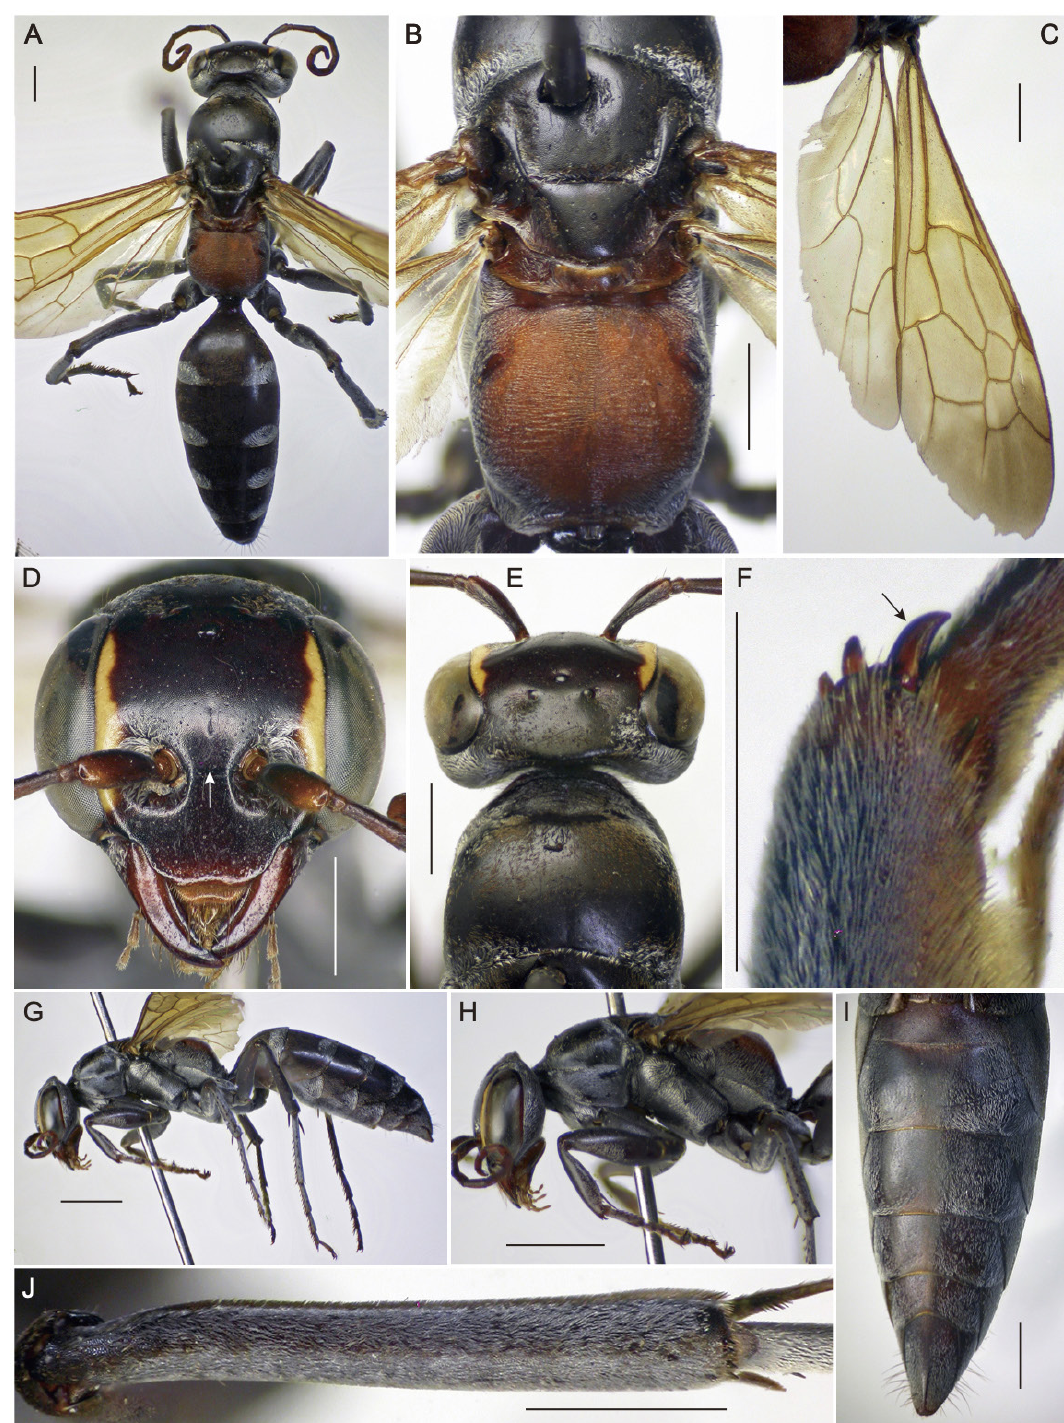
Fig. 3. Ctenocerus srilankae Shimizu sp. nov., holotype, ♀ (NMNH). A . Whole body, dorsal view. B . Posterior part of mesosoma, dorsal view. C . Right wings. D . Head, anterior view, arrow indicates frontal bridge. E . Head and pronotum, dorsal view. F . Apical part of left fore tibia, mesial view, arrow indicates apicomesial spine on fore tibia. G . Whole body, lateral view. H . Head and mesosoma, lateral view. I . Metasomal sterna 2–6, ventral view. J . Left hind tibia, dorsal view. Scale bars: A–E, I–J = 1 mm; F = 0.5 mm; G–H = 2